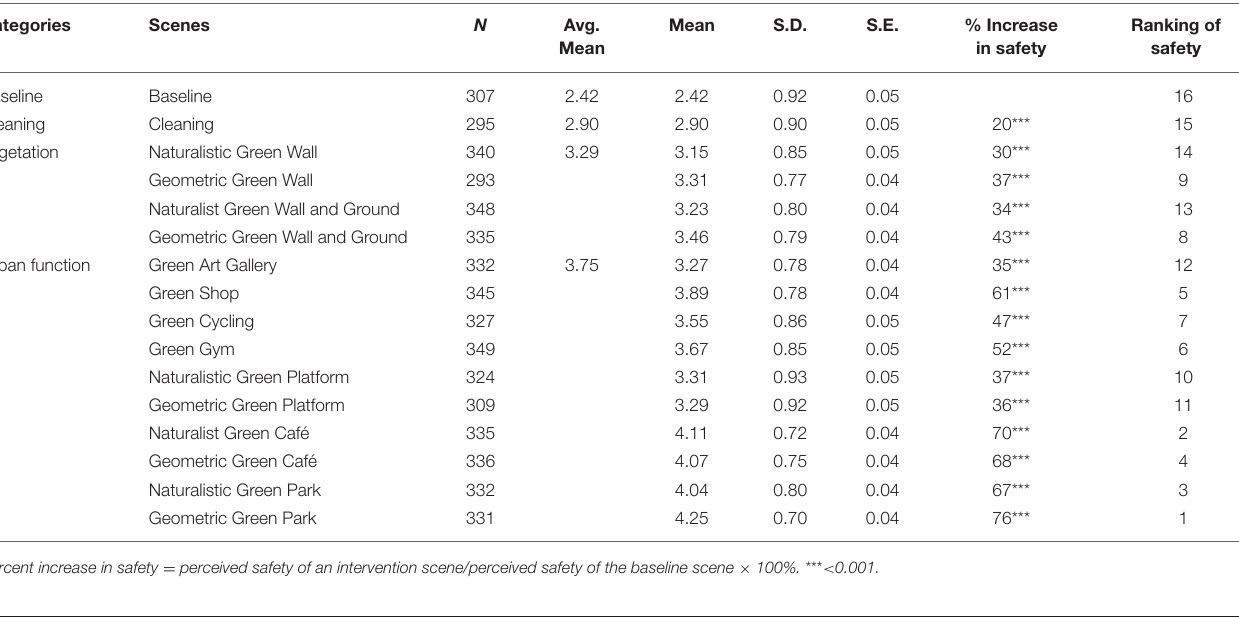
promotion effect (the Green Cycling intervention). The other three urban interventions yield a slightly lower safety promotion